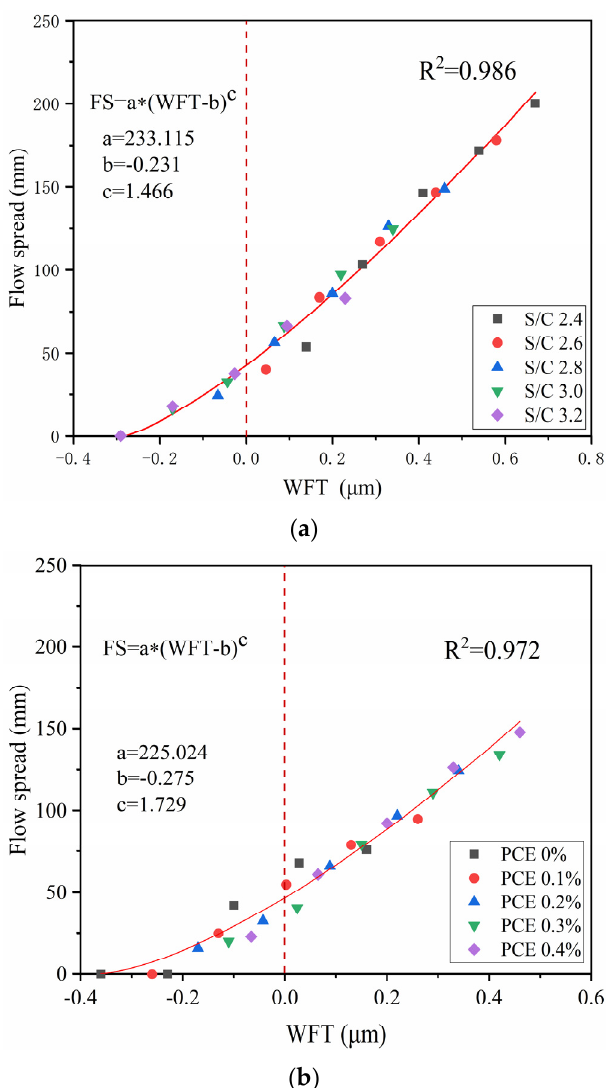
Figure 10. Flow Spread versus WFT: ( a ) different S/C Ratios, ( b ) different PCE Dosages.